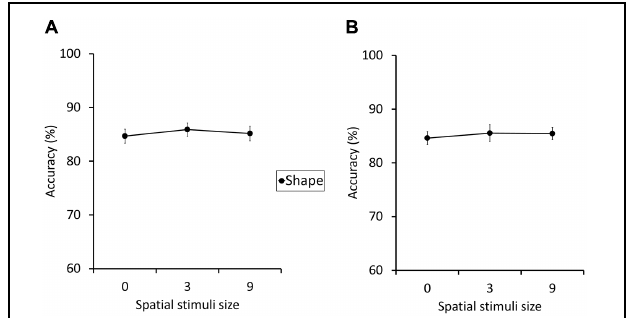
FIGURE 7 | The results of additional preliminary experiments discussed in Section “General Discussion,” depicting the accuracy (% correct) of the shape WM performance (see General Discussion for details). (A) The perceptual masking experiment (see Figure 6A ), and (B) the visual search experiment (see Figure 6B ). The error bars indicate the